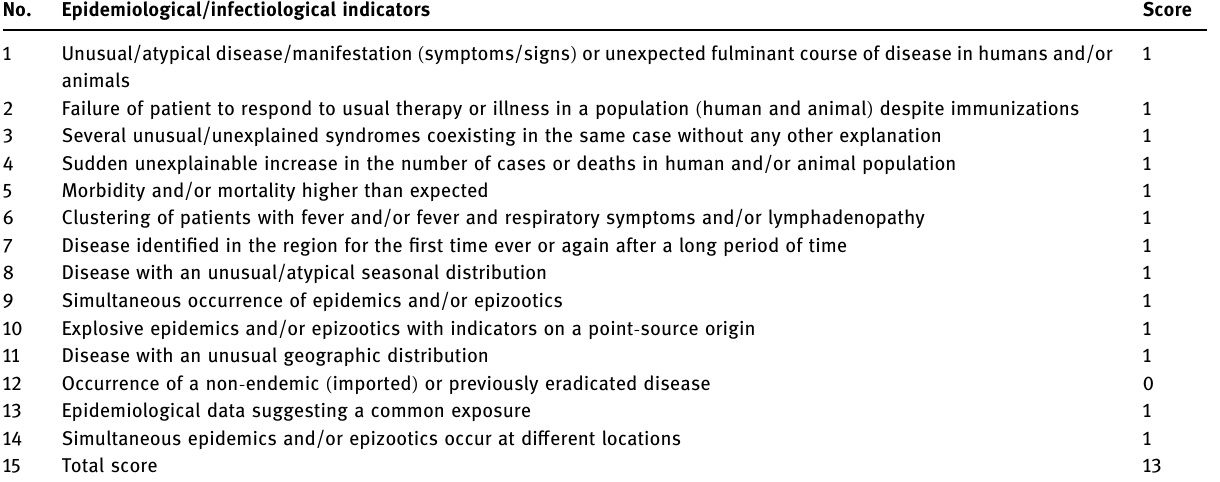
Table 1: Scoring of the COVID - 19 outbreak according to the model of Radosavljevic and Belojevic [ 7,9 ] for di ff erentiation between natural, accidental, and deliberate outbreak caused by new or re - emerging pathogen